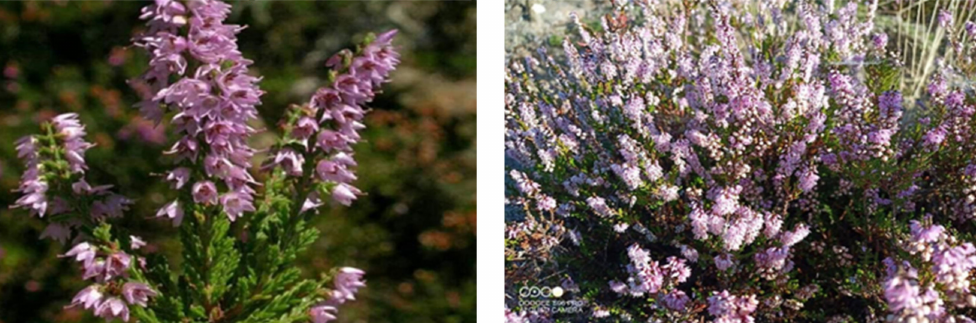
Figure 1. C. vulgaris plant (Mihai Grama, beekeeper—personal